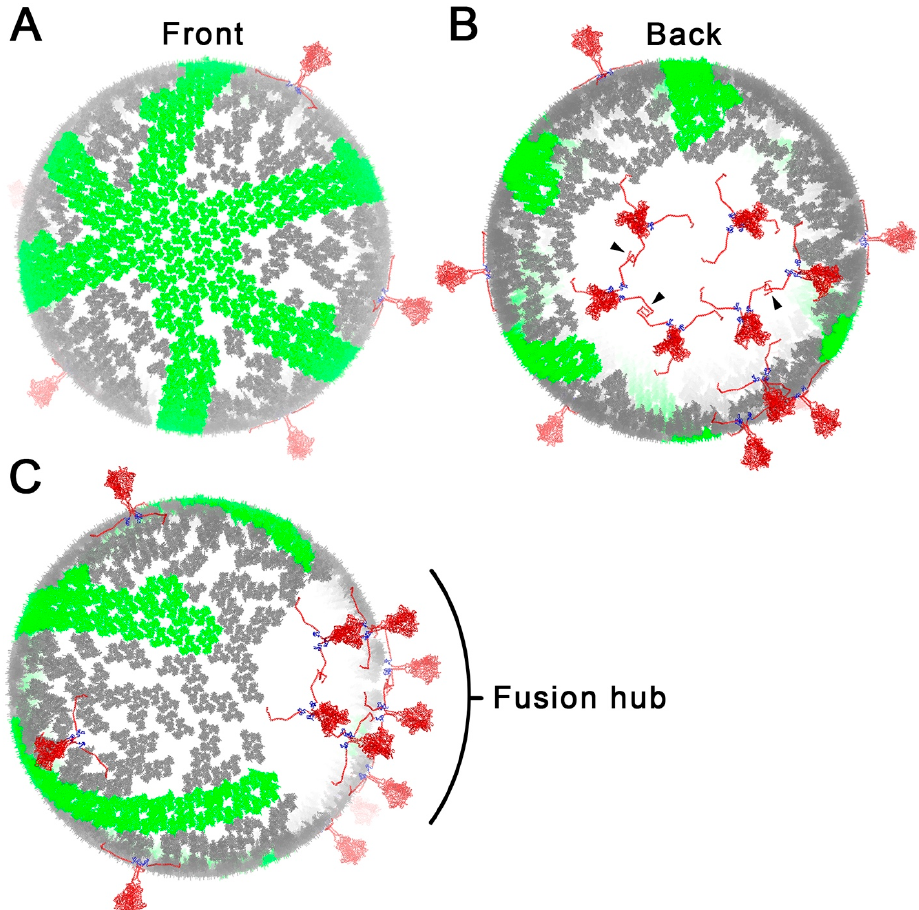
Figure 6. Conceptual model containing hexagonally arranged MA trimers and clustering of Env proteins prior to viral entry. Mathematically feasible trimers are shown in green while the Env protein is depicted in red and blue. ( A ) Front view of a hypothetical HIV-1 particle with mathematically feasible trimers in green and Env proteins in red scattered throughout the matrix. Grey MA trimers do not form hexagons. ( B ) Back view of ( C ) showing the fusion hub opening where Env proteins interact. Arrow heads point to the interactions between adjacent Env proteins promoting clustering. ( C ) Perspective view showing the fusion gap.